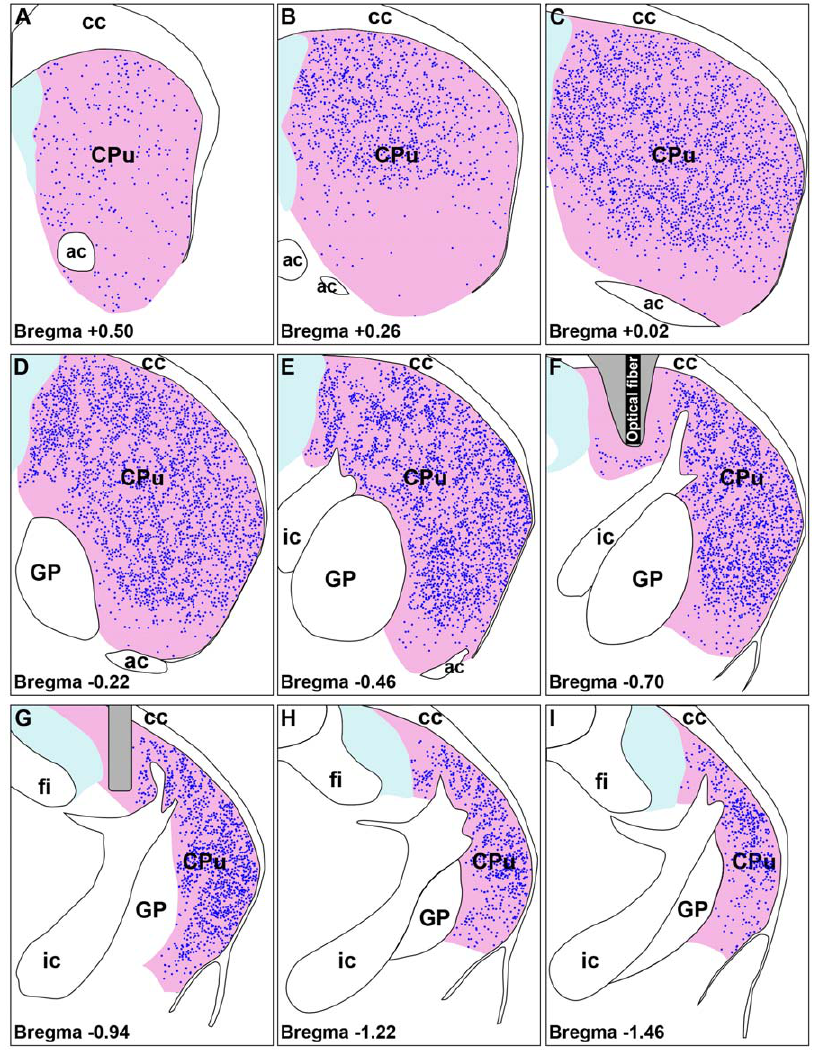
Figure 4. Distribution of Npas4 ISH signals in the striatum after unilateral blue light illumination. Schematic diagrams of the striatum were constructed by superimposing images of stained coronal tissue sections on figures from a standard mouse brain atlas [27]. Npas4 ISH signals in the illuminated striatum (CPu) are represented by blue dots. Signals outside the striatum are not shown. (A–I) Photoactivation-induced expression of Npas4 in the mouse striatum is shown from bregma + 0.50 mm to bregma 2 1.46 mm. The location of the optical fiber is depicted in F. The areas adjacent to the optical fiber appear in gray shade (F, G). (D–H) Strong Npas4 induction took place in almost the entire extent of the striatal region close to the optical fiber. (A–B) Npas4 expression level was relatively weaker along the ventral part of the rostral striatum. ac, Anterior commissure; cc, Corpus callosum; CPu, Caudate putamen; fi, Fimbria of the hippocampus; GP, Globus pallidus; ic, Internal capsule.